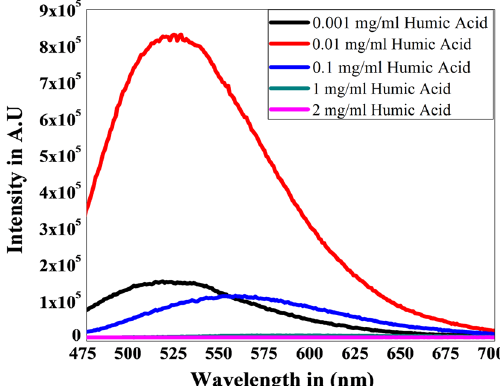
Fig. 2 Fluorescence spectra (λ